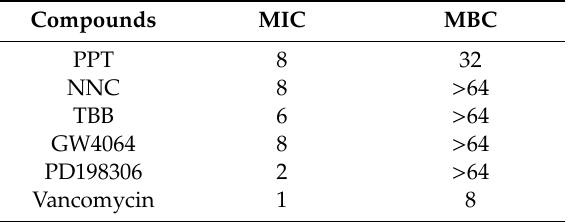
Table 3. Antibacterial activity ( µ g / mL) of compounds against MRSA MW2.